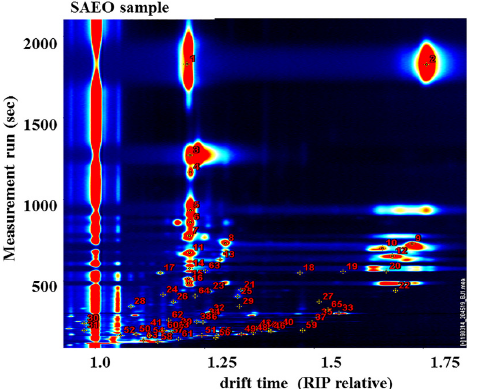
Figure 4. Typical GC-IMS topographic map of SAEOs. The compounds of the SAEOs were labelled by searching the GC-IMS map library. A compound can produce multiple signals (monomer, dimer, or trimer), for example, 1 and 2 are anethole, and 1 is a monomer and 2 is a dimer. The whole spectrum represents the headspace composition of the sample.